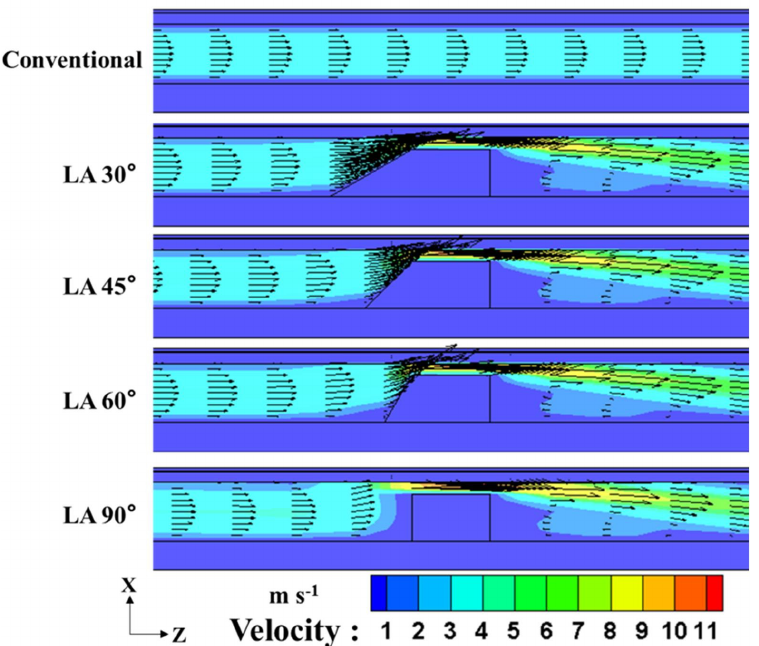
Figure 21. The influence of the baffle block-leading sloping angle on the velocity distribution in the PEM fuel cell cathode flow channel